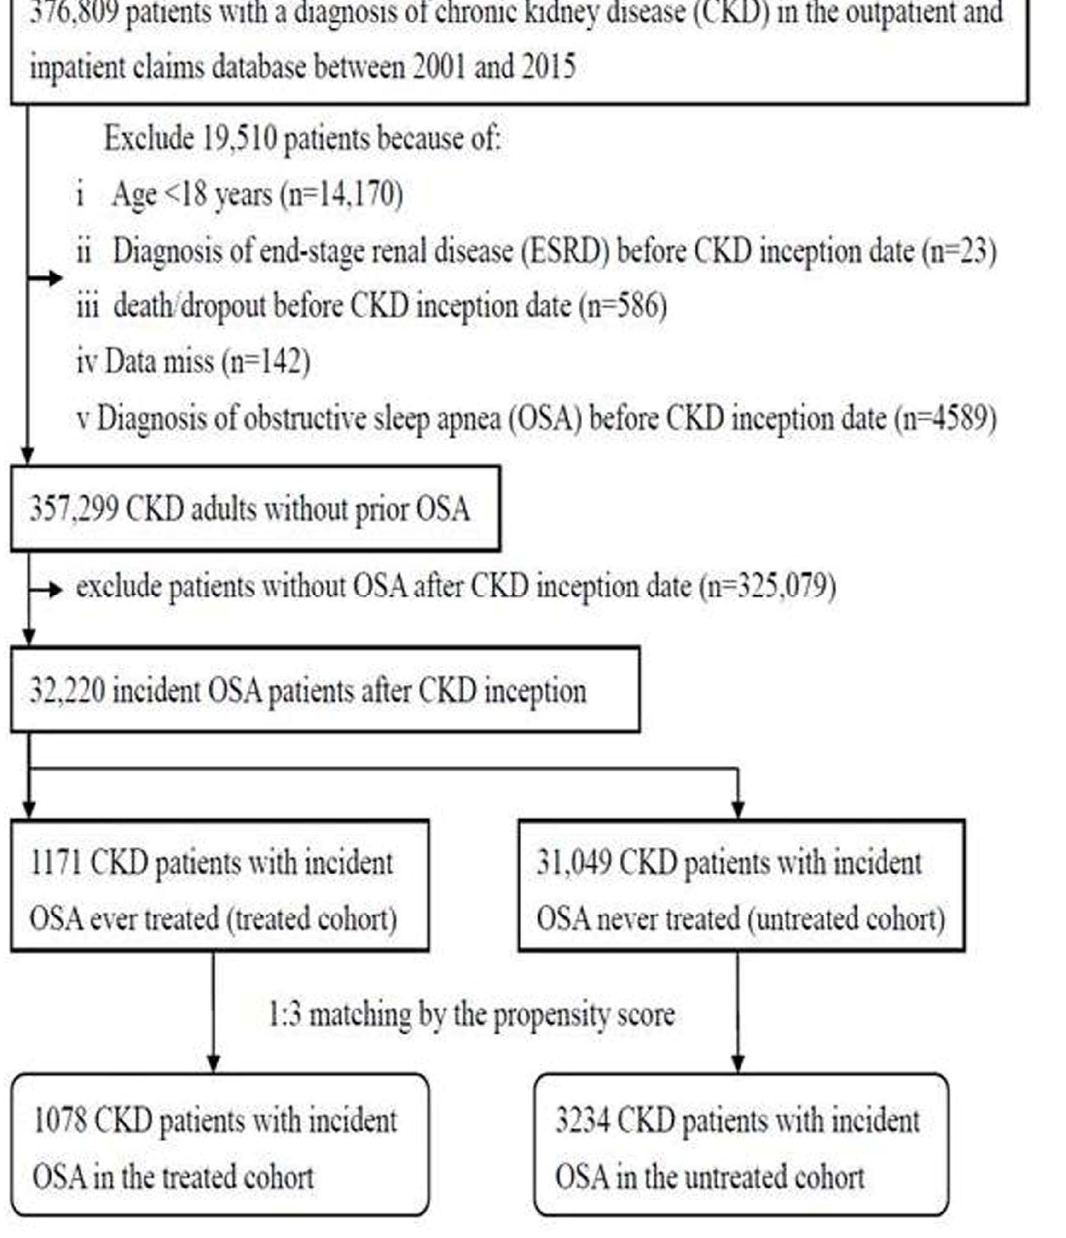
Figure 1. Flow diagram of the enrollment process.